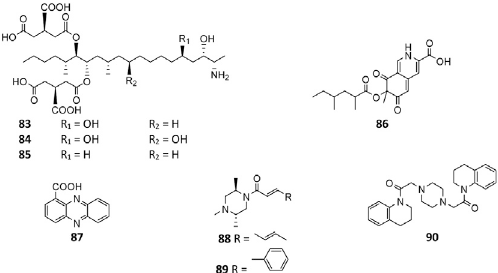
FIGURE 7 | Proposed biosynthetic pathway of